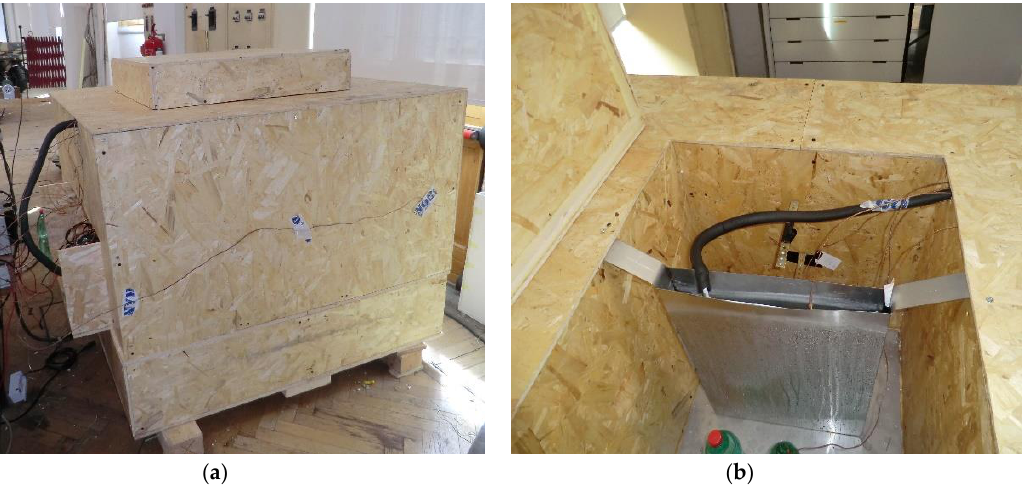
Figure 3. ( a ) External and ( b ) internal views of the first prototype of the system used for testing purposes.